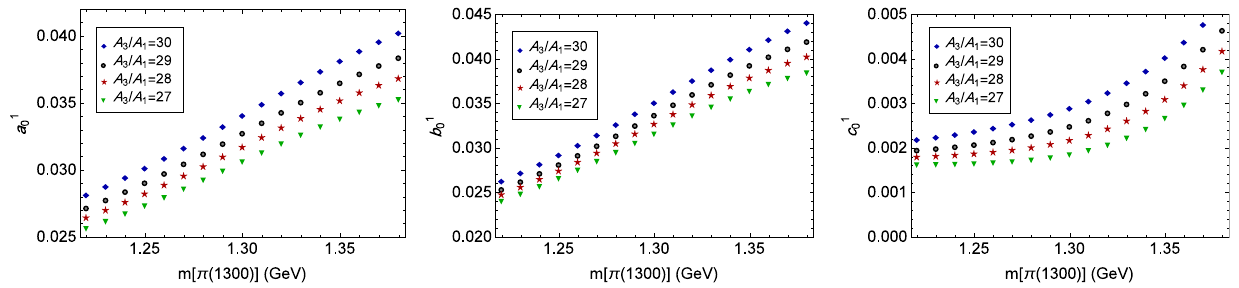
Fig. 12 The J = 0, I = 1, elastic πη scattering lengths in GLSM for different values of A 3 / A 1 and m [ π( 1300 ) ]